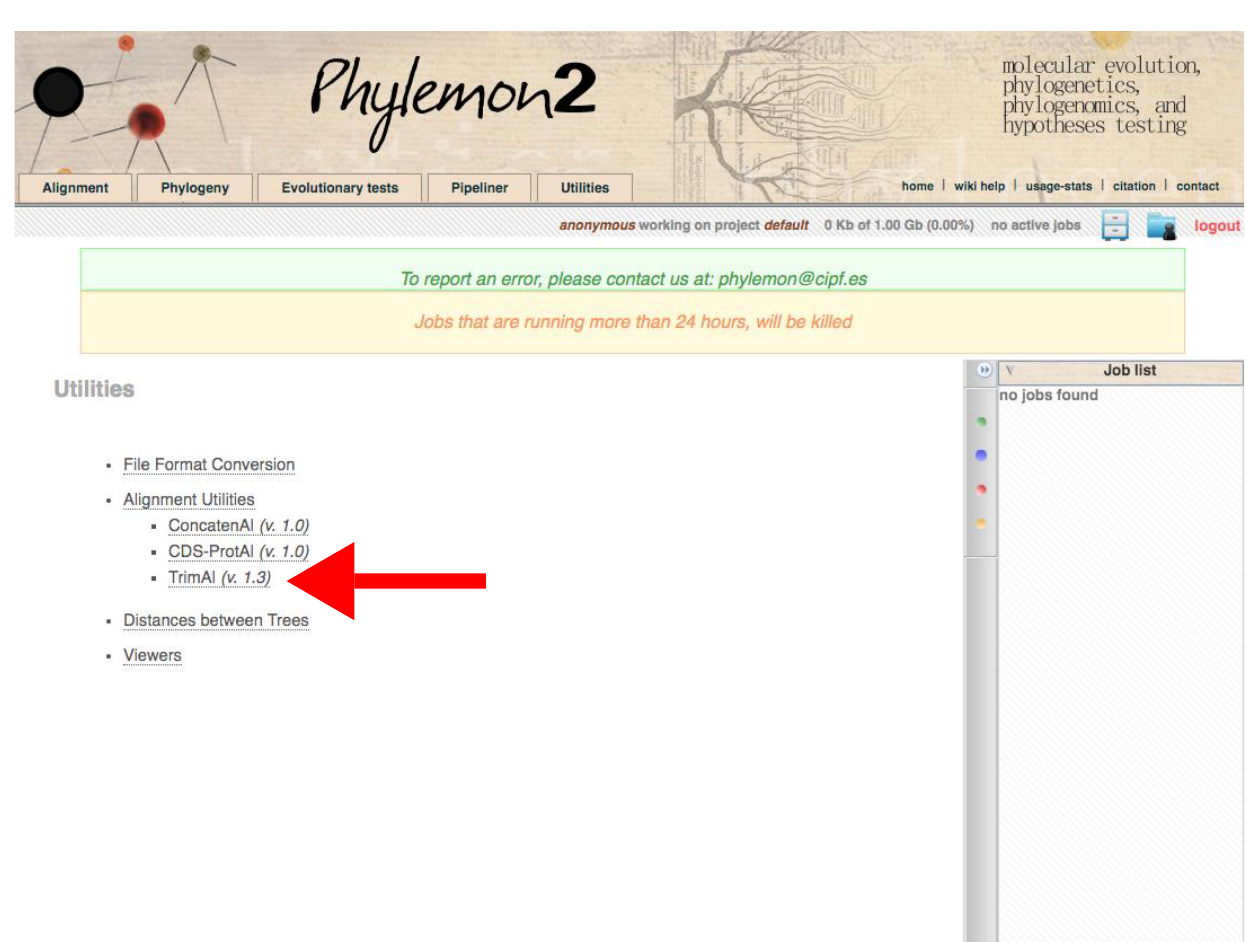
Figure 11. Phylemon2 Utilities web server. The red arrow indicates the trimAl program. Accessed on 27 January 2022.